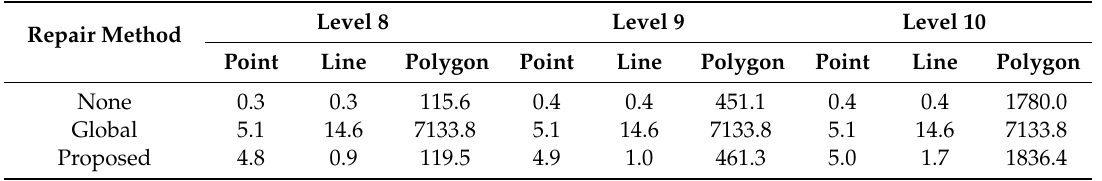
Table 4. Execution time of the gridding results of the three methods (second).